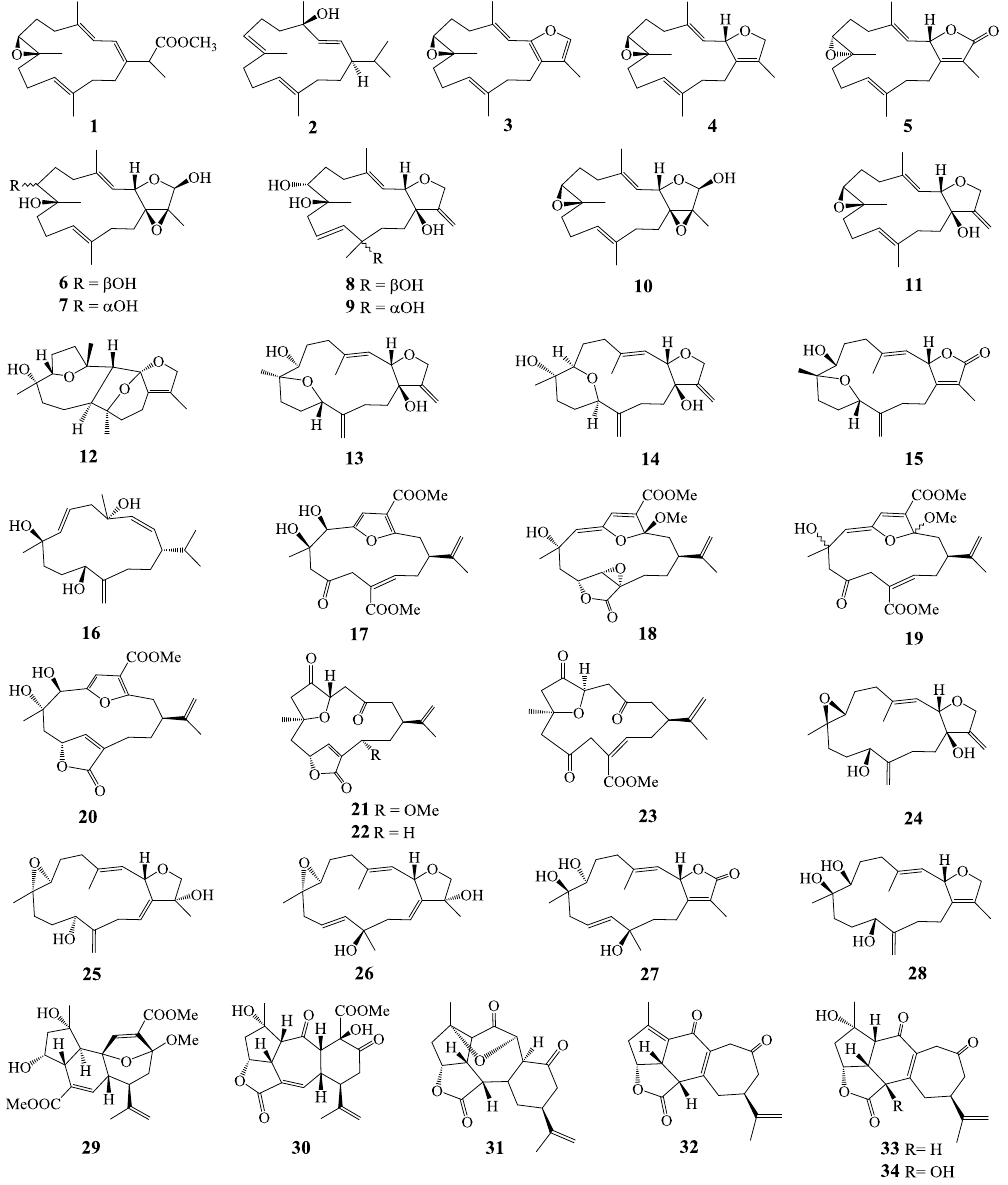
Figure 1. Chemical structures of cembrane-type diterpenes 1 – 34 isolated from Vietnamese soft